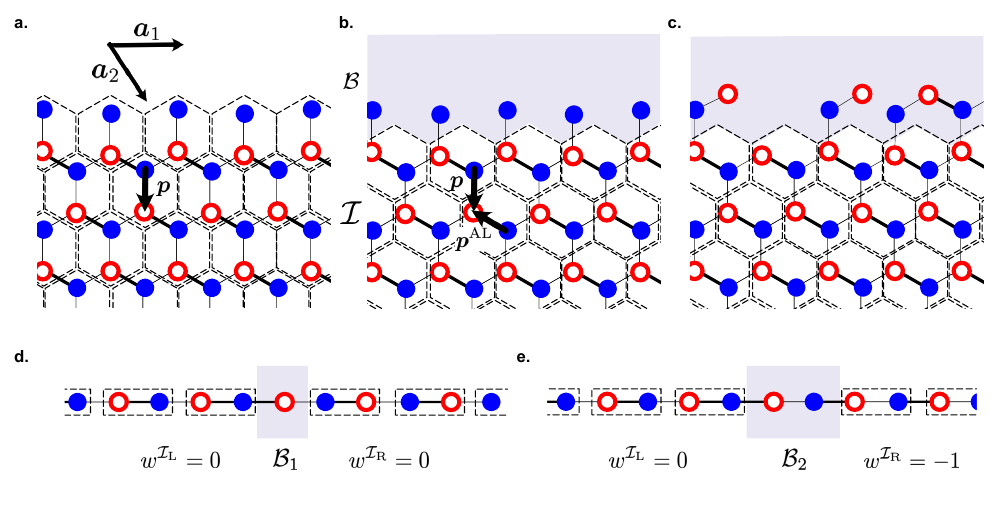
Figure 4: Bulk-boundary correspondance. a . A chiral crystal defined on a honey- comb frame is terminated by a clean zigzag edge incompatible with the atomic-limit Hamiltonian defined by keeping only the dominant couplings represented by thick solid lines. The dashed rectangles indicate the Wigner-Seitz cells allowing a tes- sellation compatible with the edge geometry. The arrow indicates the geometrical polarization p . b . Same physical system. The crystalline bulk is now tiled using the unit cell compatible with the atomic limit. This requires a redefinition of the crystal boundary B (shaded region). The arrows indicate the geometrical polarization of the new unit cell ( p AL ). The difference p − p AL is a Bravais lattice vector ( a ). c . Same 2 material as in ( a .) and ( b .) including a disordered interface B bearing a non-zero chiral charge M B . d . Two connected SSH chains. The Wigner-Seitz cell in the two materials are compatible with their atomic limits. The interface B separating the 1 two materials is one-site wide. e . Redefining the Wigner-Seitz cell on the right hand side of the interface requires widening the boundary region. This redefinition makes the unit cell incompatible with the atomic limit. The winding of the Bloch Hamilto- nian in I takes a finite value and consequently modifies the zero-mode content of R the boundary